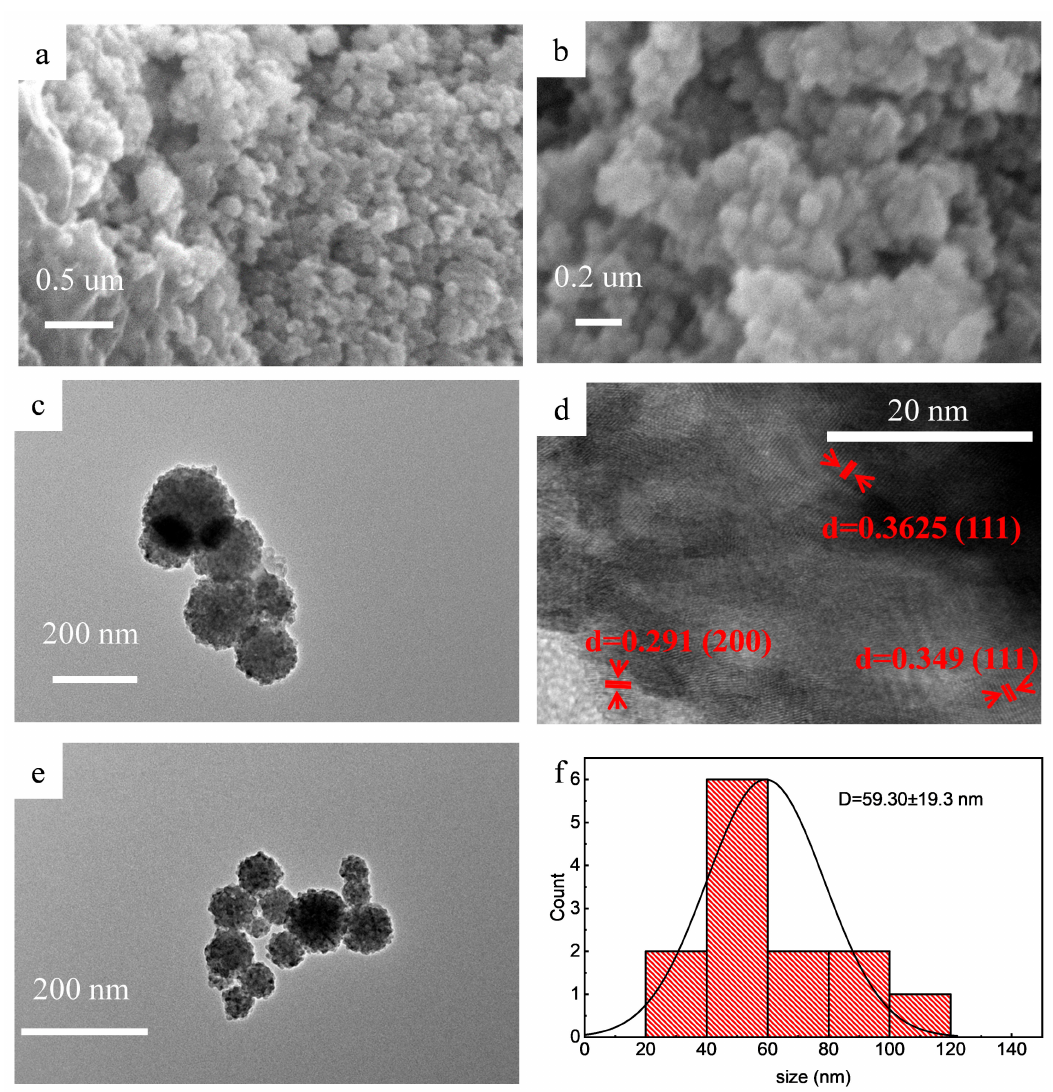
Figure 2. SEM images of CdS ( a , b ), TEM images of CdS ( c – e ), and histogram of particle size ( f